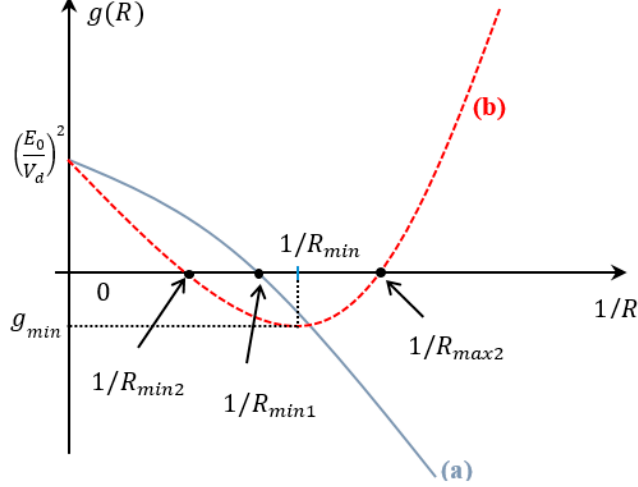
Figure 5. Different plots of the function g ( R ) of (13). ( a , b ) represent respectively the curve of g ( R ) when R 2 o < 4 × r × R ac and R 2 o > 4 × r × R ac .